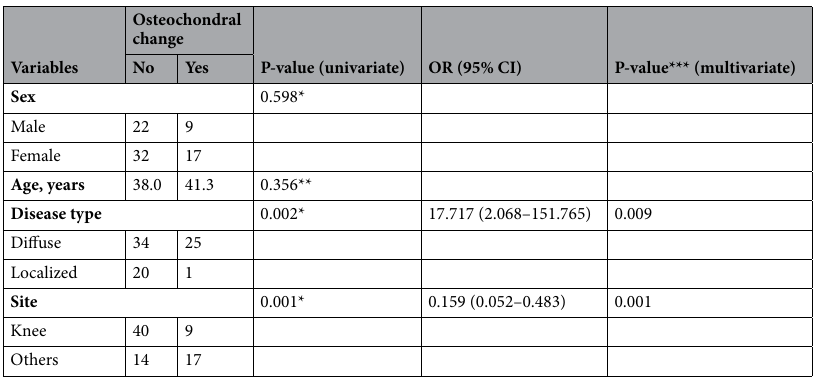
Table 3. Factors influencing osteochondral change at initial examination. OR odds ratio, CI confidence interval. *Fisher’s exact test and Pearson chi-square test. **Mann–Whitney U test. ***Logistic regression